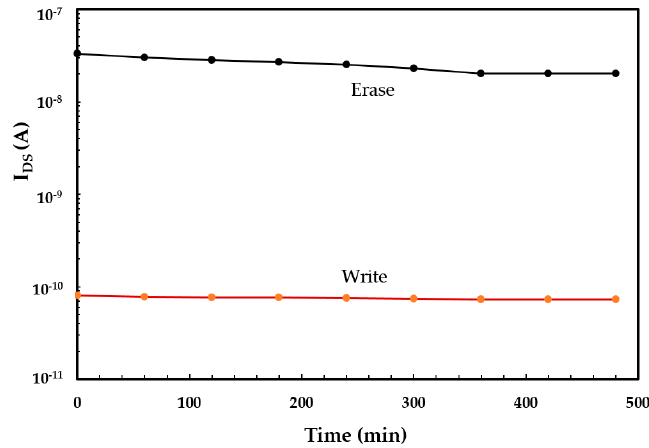
Figure 7. Charge retention capability as a function of retention time for the SWCNT-based OTFMT.